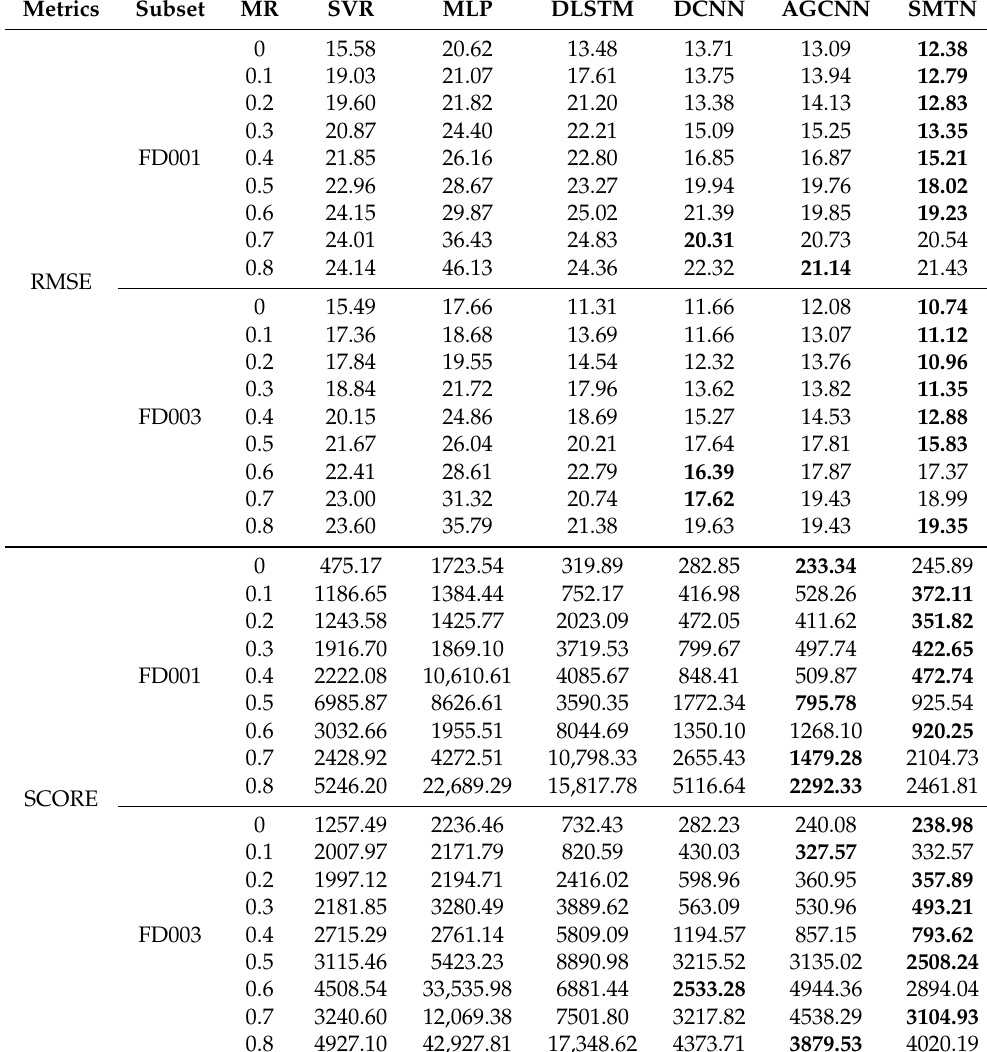
Table 4. RMSE and the score of compared methods on C-MAPSS under different